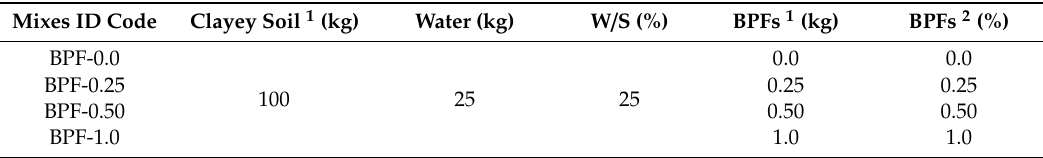
Table 2. Earthen mix ID codes and proportions of materials used in each mix. Mixes ID